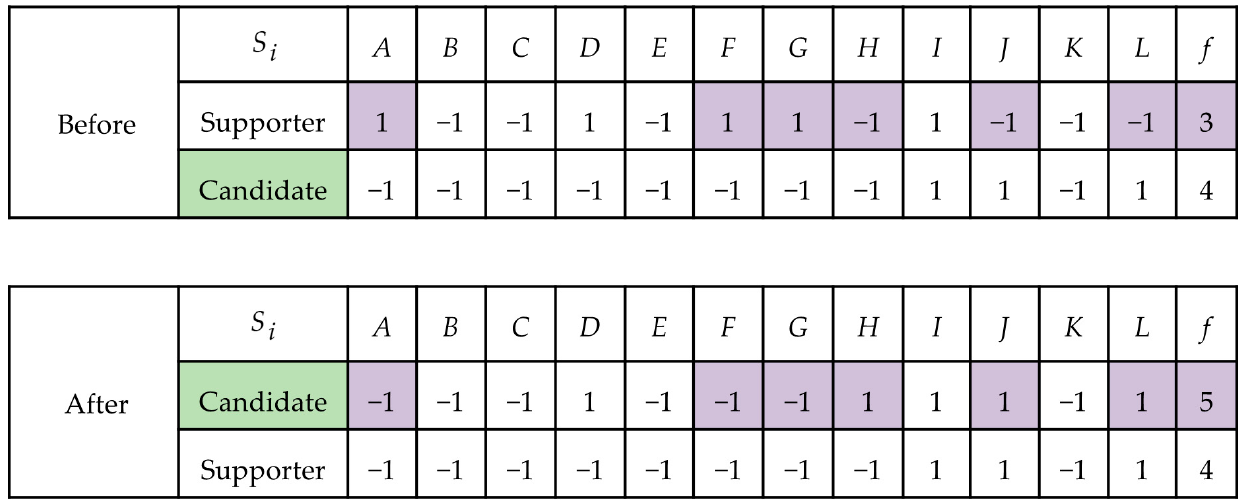
Figure 1. Updating and replacing the supporting voter as the new